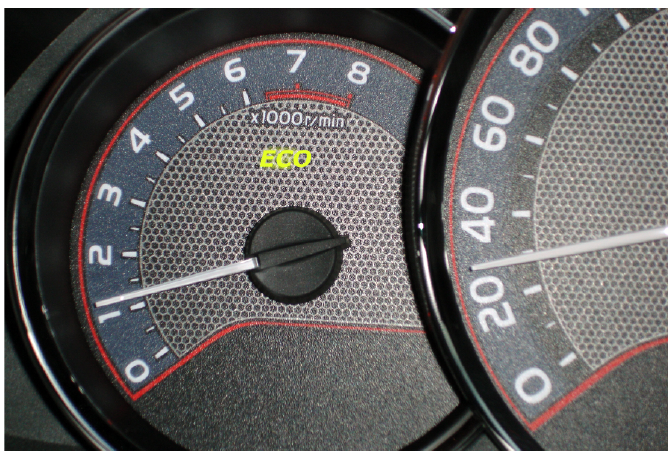
Figure 4. An example of a car dashboard with an “ECO” indicator, showing whether a driving mode is economical or